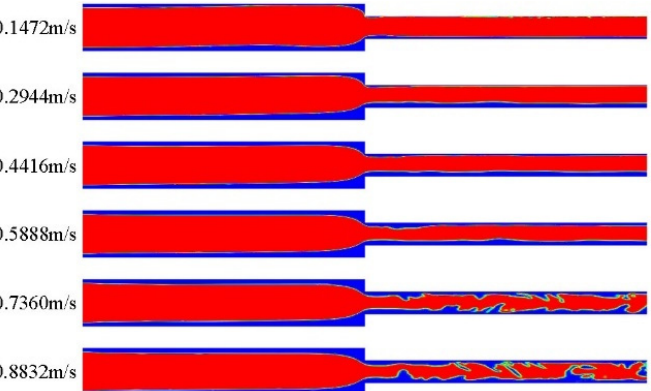
Figure 8. The oil–water annular flow inside the sudden-contraction pipe. ( v w = 0.1472 − 0.8832 m/s, v o = 0.7056 m/s).